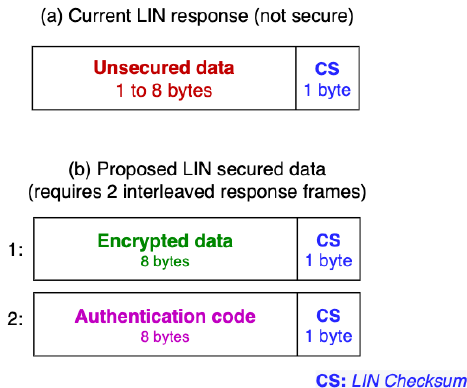
Figure 3. ( a ) Current usage of the response’s data field; ( b ) Proposed usage of this field, with secured data.